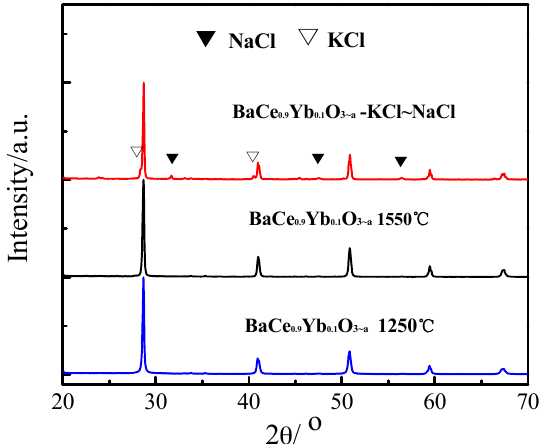
Figure 2. X–ray diffractometer (XRD) patterns of BaCe 0.9 Yb 0.1 O 3 −α (1250 °C, 1550 °C) and BaCe 0.9 Yb 0.1 O 3 −α -NaCl~KCl.